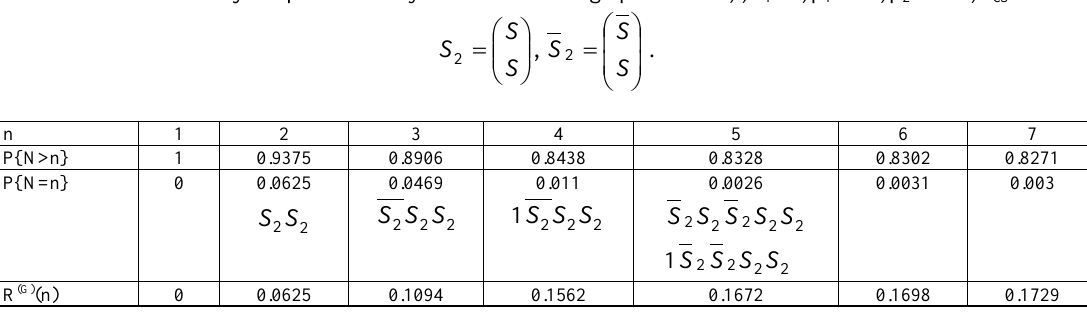
Table 8. Reliability for planar CS system with a change point M=2, , n 1 =4, p 1 =0.5, p 2 =0.25, k cs